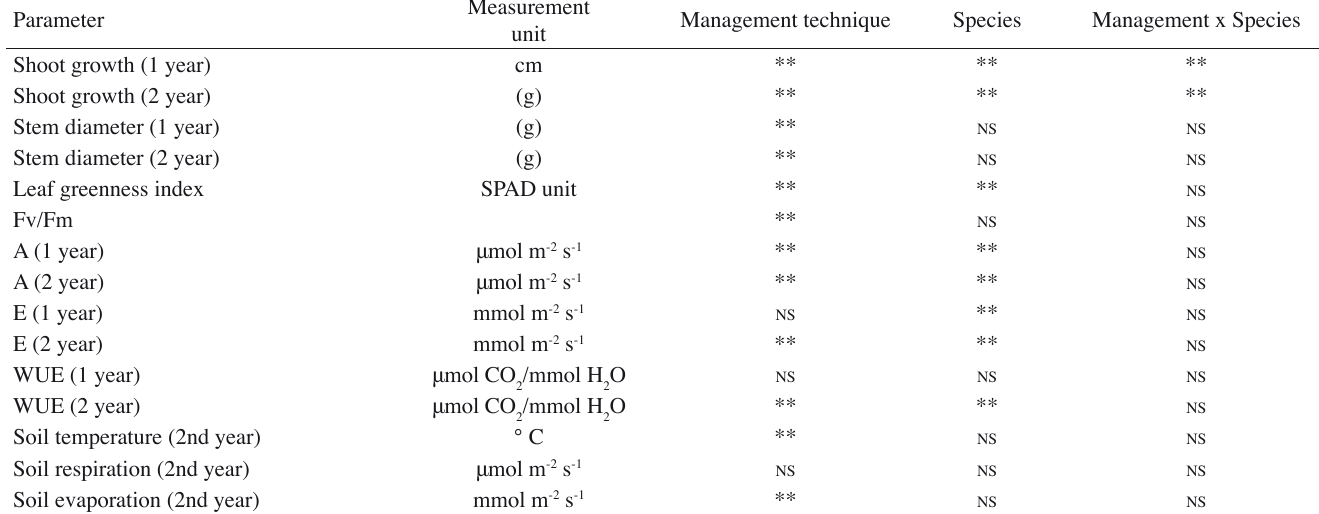
Table 1 - Summary table of Two-way ANOVA for the investigated parameters Parameter